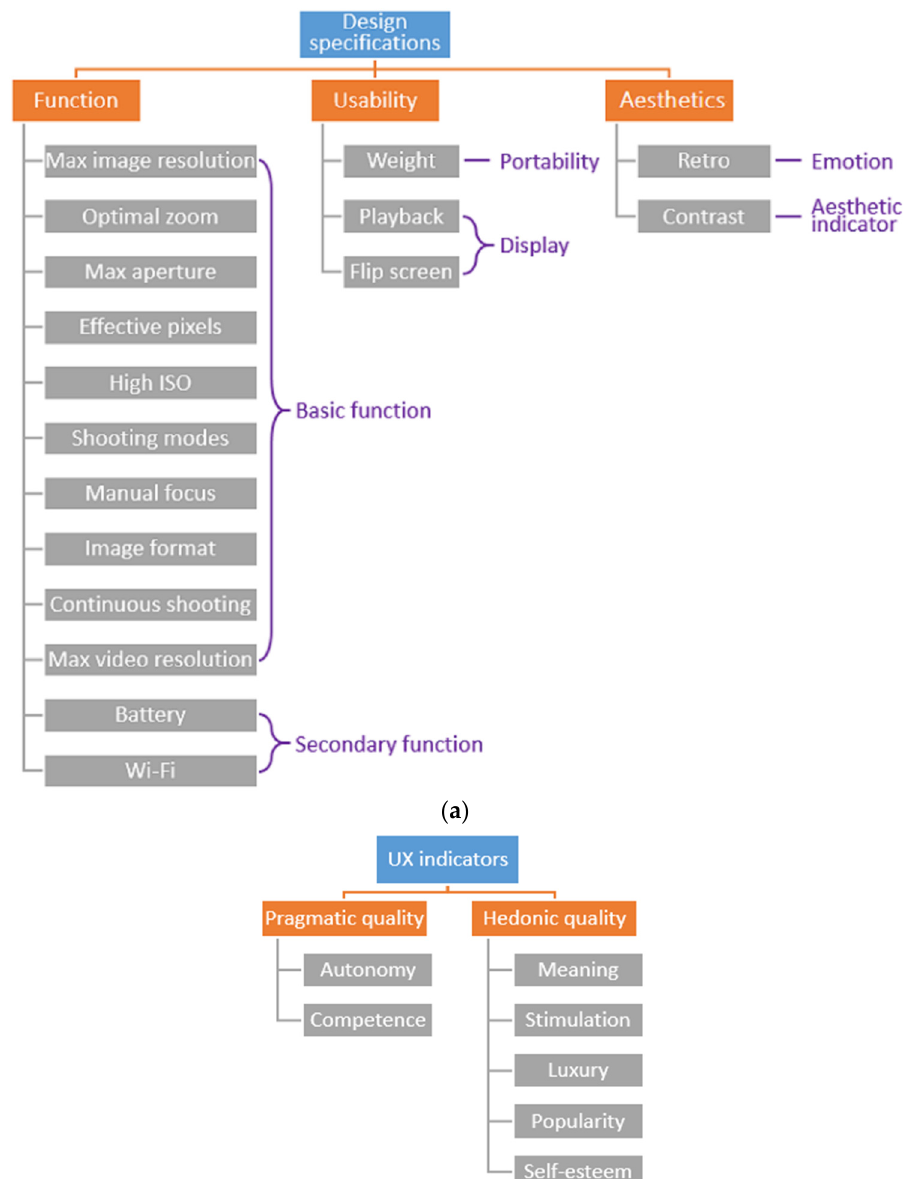
Figure 2. Design specifications ( a ) and UX indicators ( b ) of the compact digital cameras.